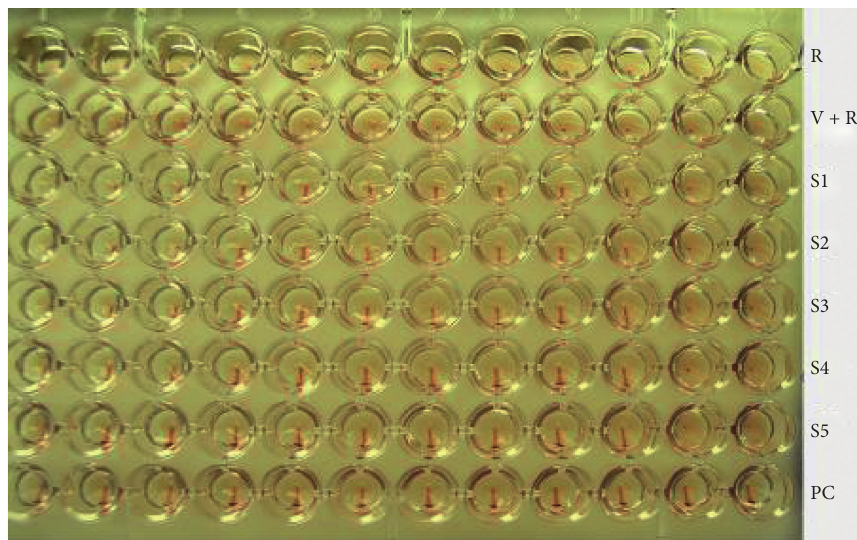
Figure 7: Hemagglutination inhibition assay of avian influenza virus. When the RBCs are alone, they will settle in the bottom of the well. Where specific antibody is absent in the clinical specimen, the viral hemagglutinin is free to agglutinate the RBCs. The HI titer of S1–S5 is 2 10 . Abbreviations: R, RBCs only; V +R, virus and RBCs; PC, positive control; S, sample (unpublished